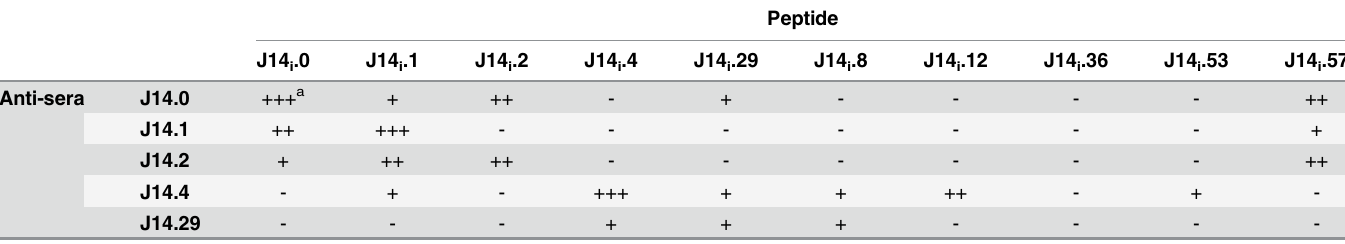
Table 4. Relative cross-recognition between peptide specific antisera and J14 i -variant